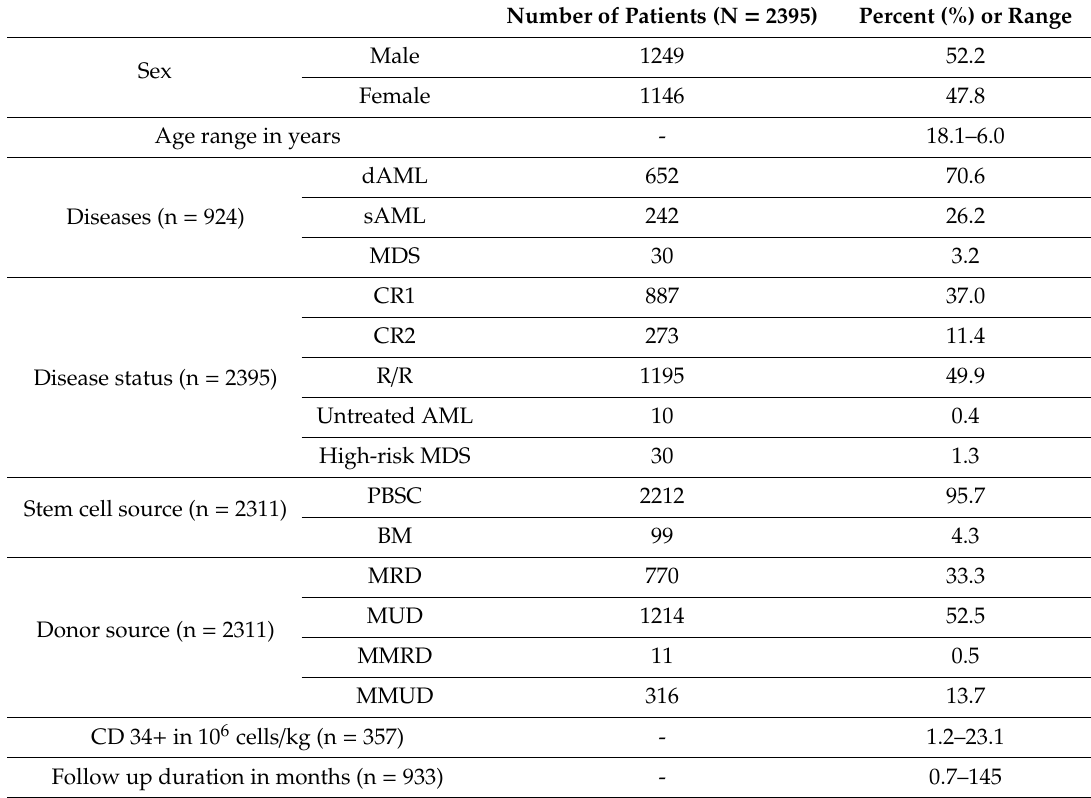
Table 2. Clinical characteristics of the patients from the included